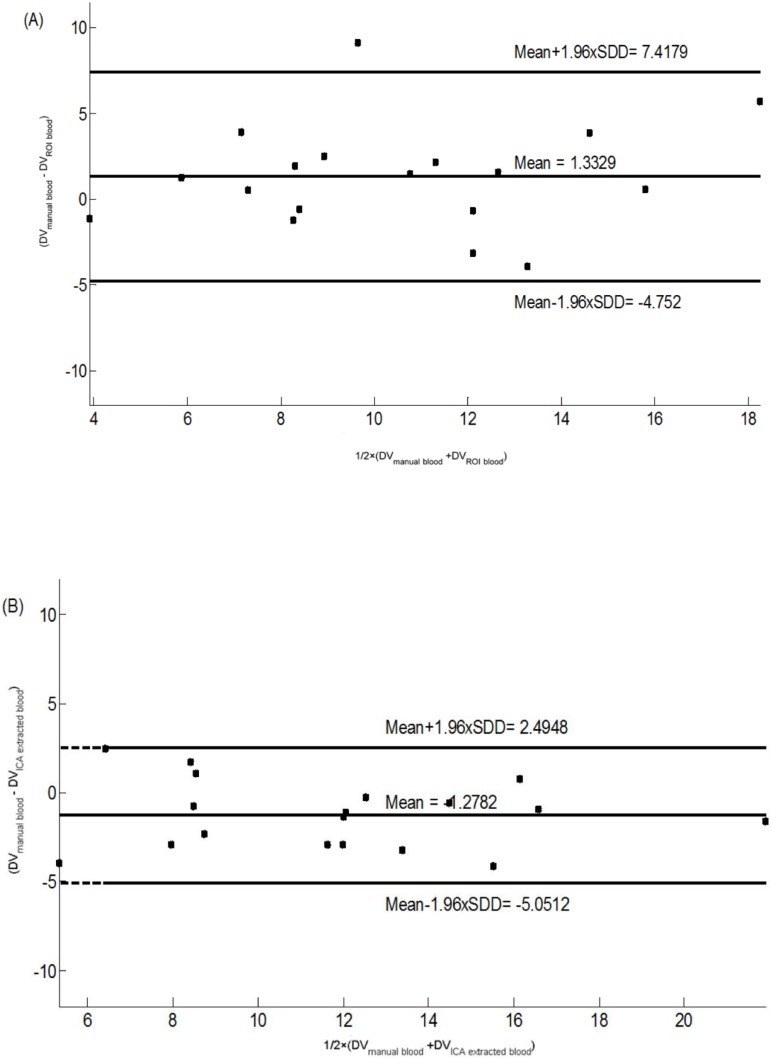
Bland Altman plot of total distribution volume (VT) in the frontal cortex comparing (A) ABSS-IF versus CS-IF, and (B) ABSS-IF versus ICA-IF.All candidates were within the 95% of limits agreed for  and , with the exception of one subject for .